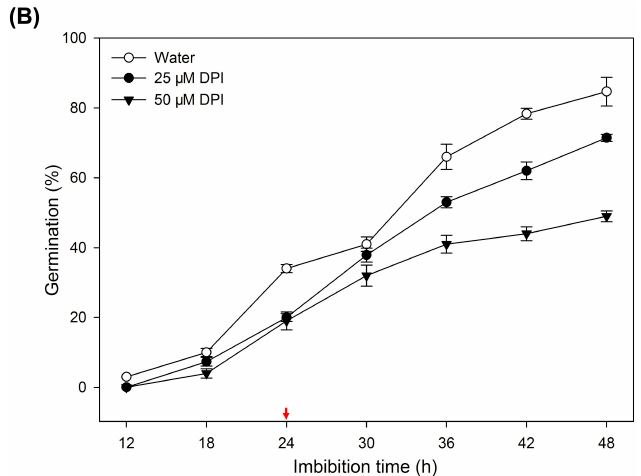
Figure 1. Morphologies and germination time courses of rice seeds in water and in the presence of diphenyleneiodinium (DPI). ( A ) The morphologies of rice seeds incubated in water or 25 μ M DPI at different time points. The first seeds to complete germination sensu stricto were observed with the radicle protrusion from coleorhiza at 24 h. Scale bar, 1000 μ m; ( B ) The germination time courses of rice seeds incubated in water or with DPI (25 or 50 μ M). Germination was scored every 6 h for a total of 48 h, and the results are presented as the cumulative germination percentage. Data represent the mean ± SE of three biological replicates of 100 seeds each. The time point for the first seeds to complete germination sensu stricto was labeled with a red arrow.